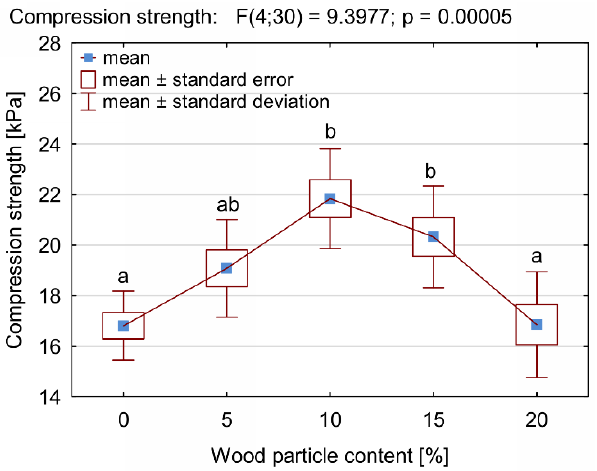
Figure 11. Compression strength of PUR-WP composition depending on wood particle content. Different letters indicate homogeneous groups of mean values determined by one-factor ANOVA with Tukey’s test.